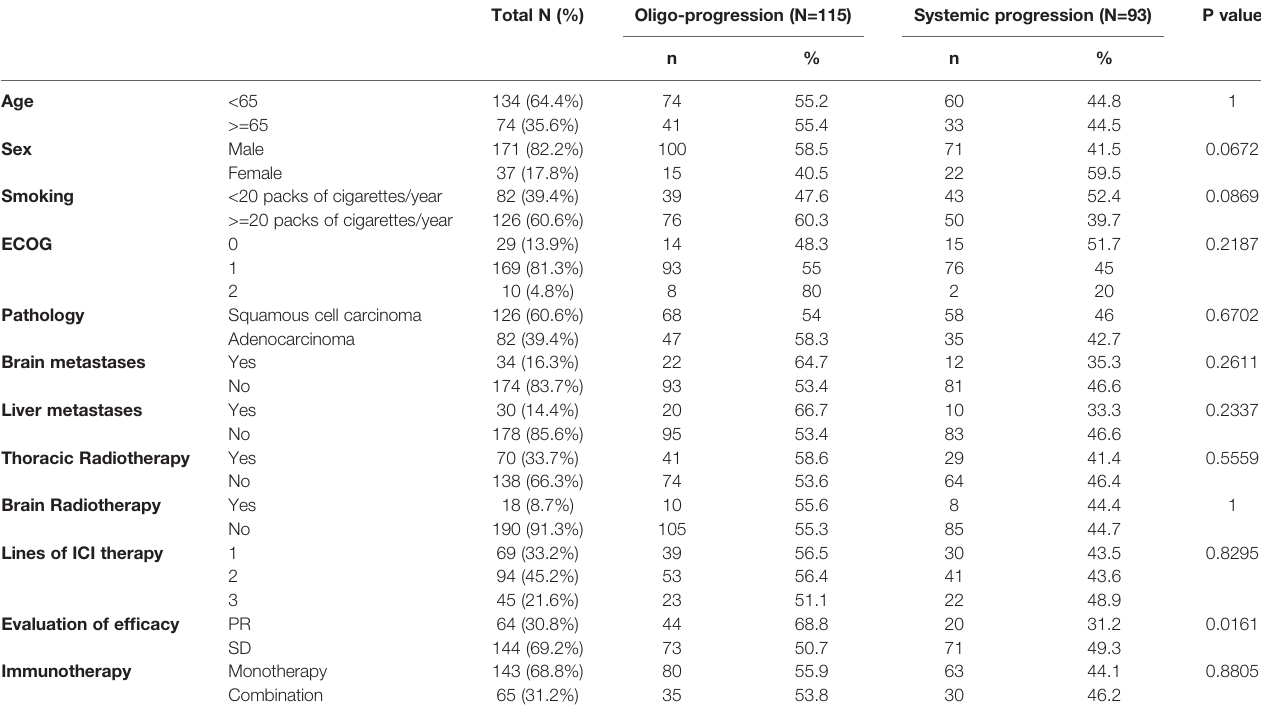
TABLE 1 | Baseline characteristics of included patients and its correlations with progression model (N=208).